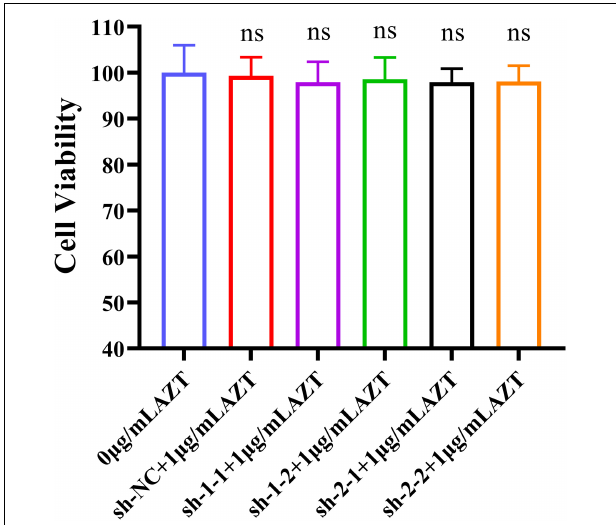
FIGURE 4 | Cell viability of DF-1 cells after the co-treatment with AZT at 1 µ g/ml and shRNA expression plasmid for 48 h by CCK-8 assay. The experiment was repeated three times. The error bars represent the SD. ns represents not statistically significant.